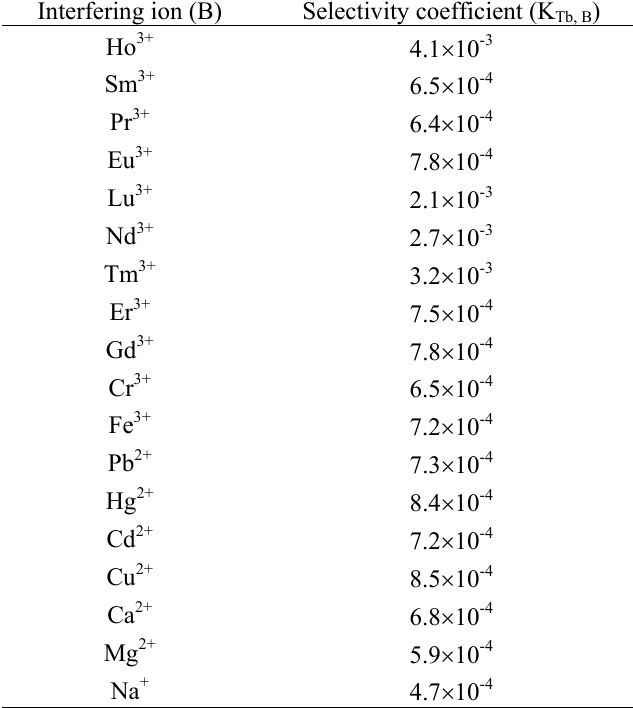
Table 2. Selectivity coefficients of various interfering